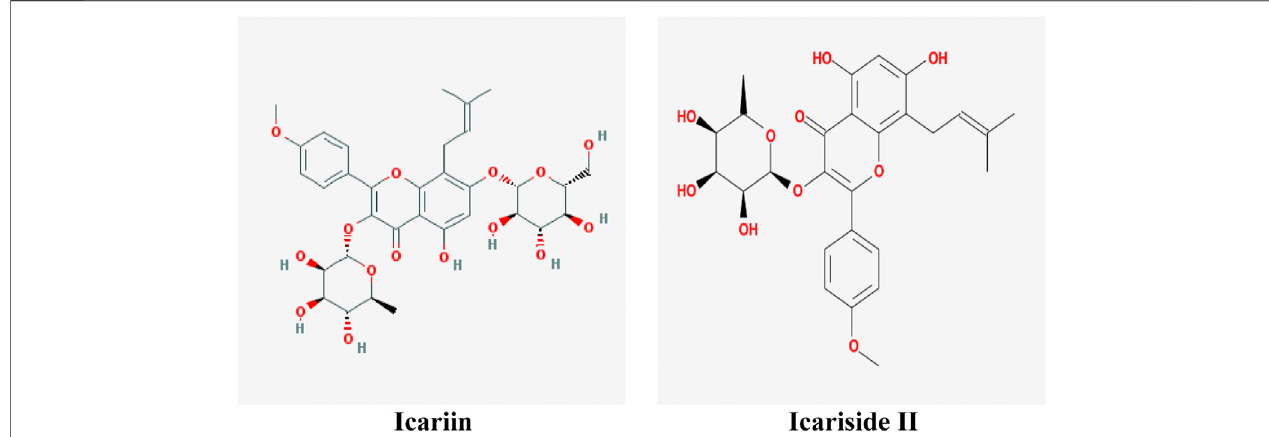
FIGURE 1 | Molecular structure of icariin and Icariside